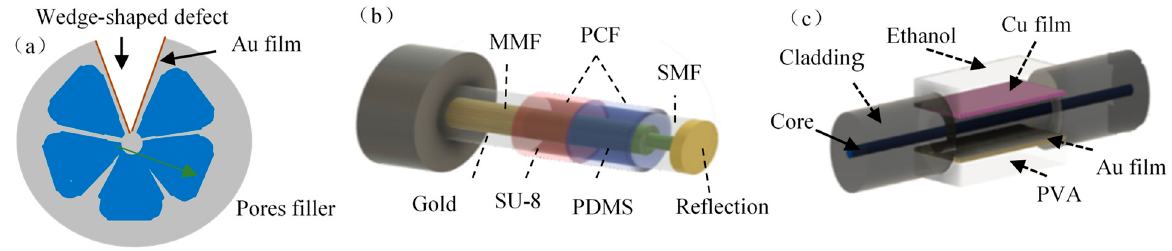
Figure 7. ( a ) a six-wedge-hole fiber-optic sensing structure [82]; ( b ) a reflective three-parameter sensor [85]; ( c ) a dual-D humidity sensor [86].